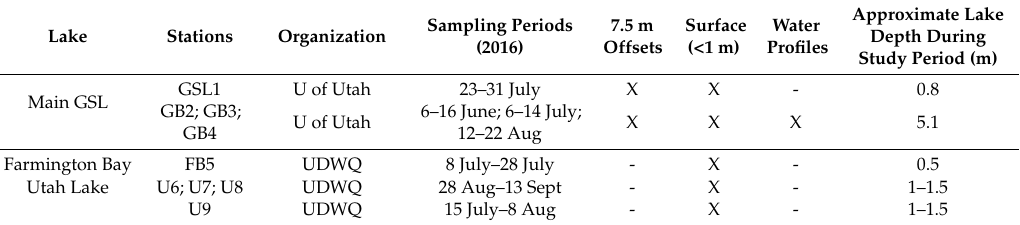
Table 1. Summary of Data Collection Periods and